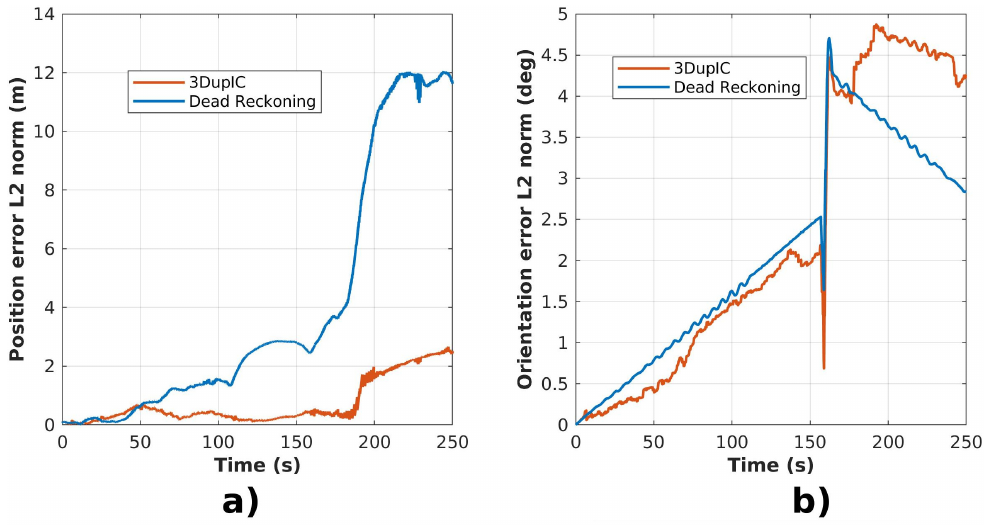
Figure 8. Error comparison between the dead reckoning and the 3DupIC aided dead reckoning solutions. In ( a ), the position error is represented as the Euclidean distance with respect to the ground truth. Similarly, plot ( b ) contains the orientation